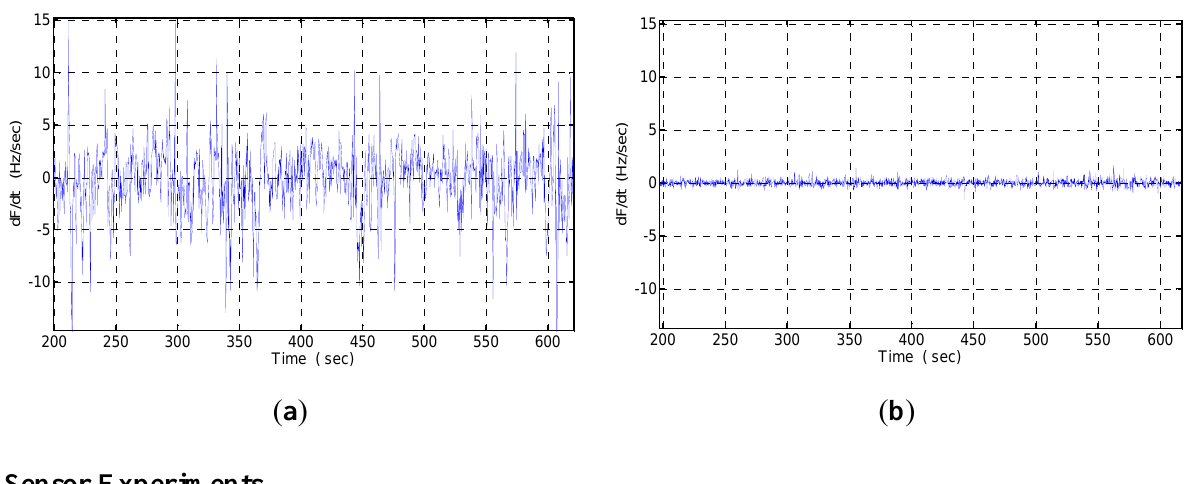
( a ) central frequency point, and ( b ) at the lowest insertion loss